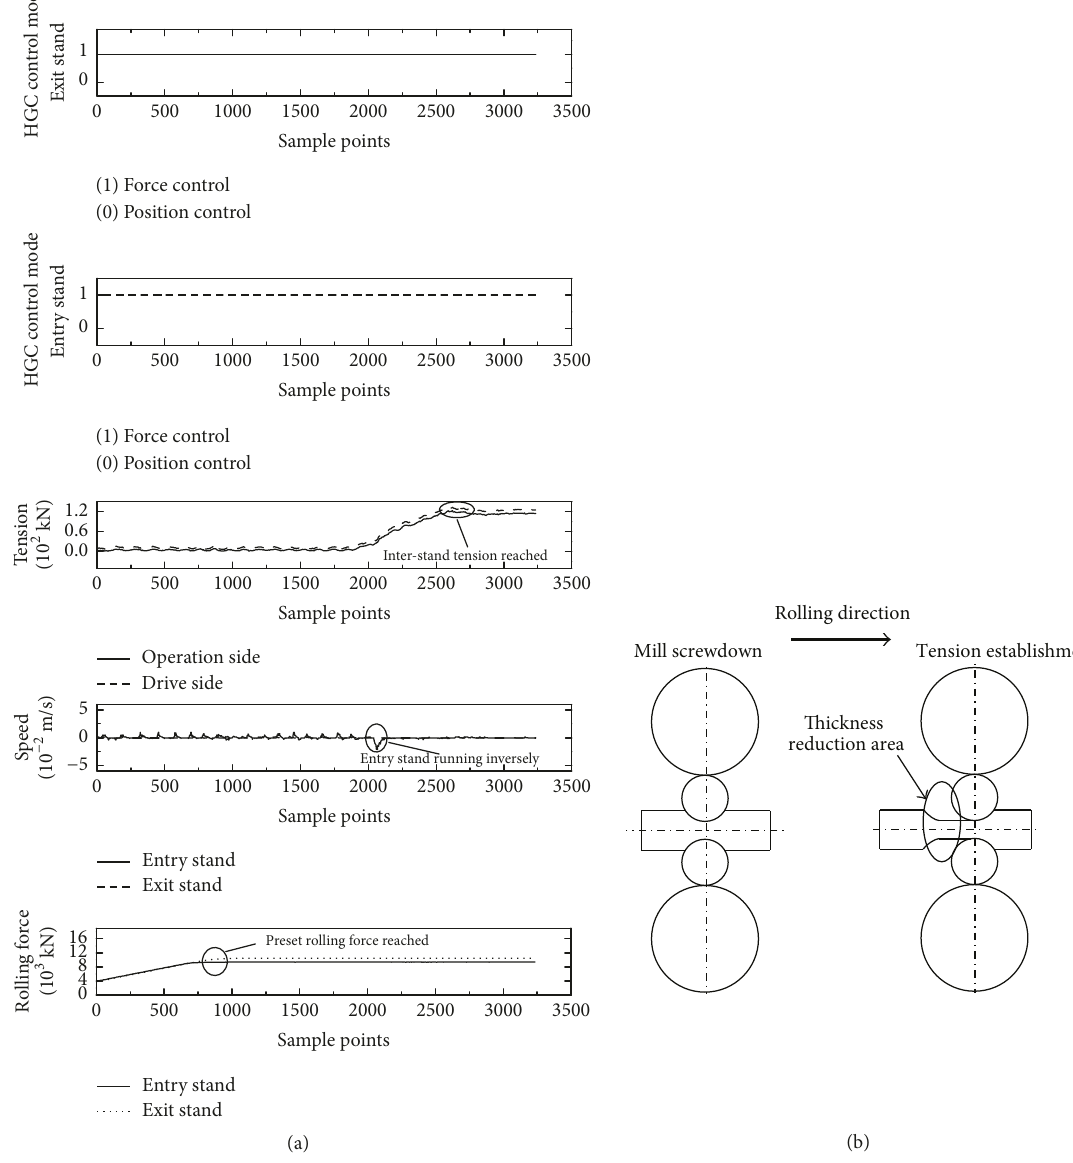
Figure 3: Schematic diagram and PDA of interstand tension establishing process: (a) schematic of interstand tension establishing process; (b) tension establishing process by entry